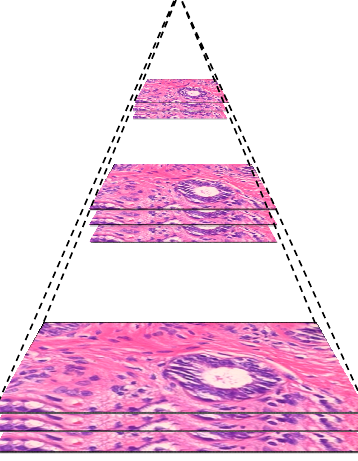
Figure 5. The image pyramid of inputting image.